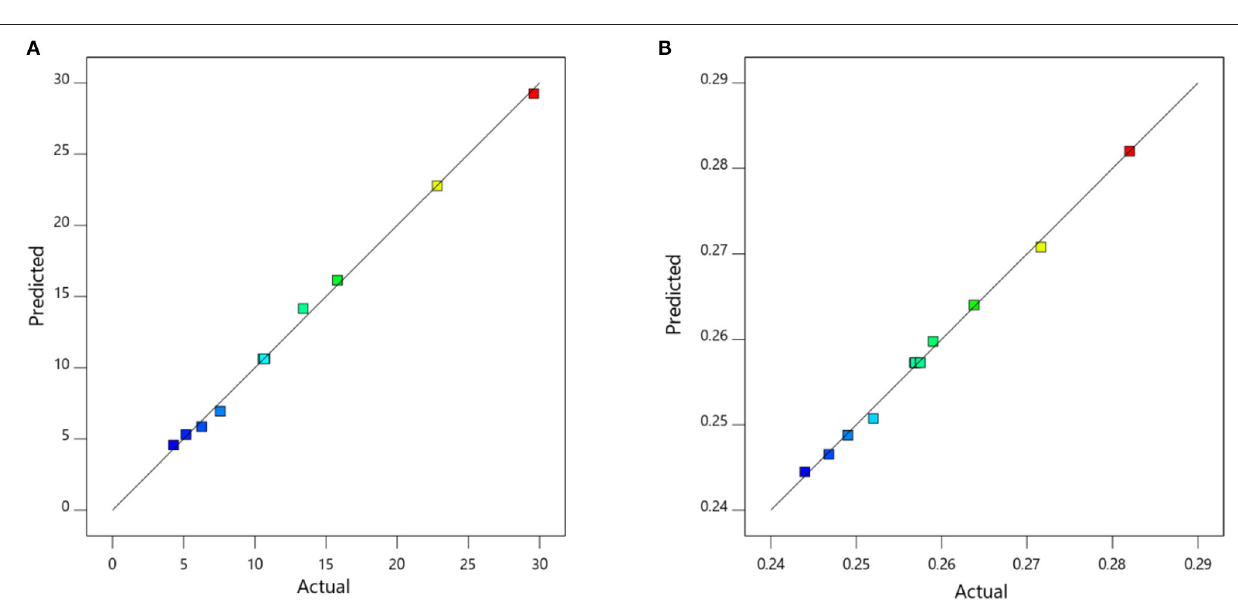
Frontiers in Mechanical Engineering |